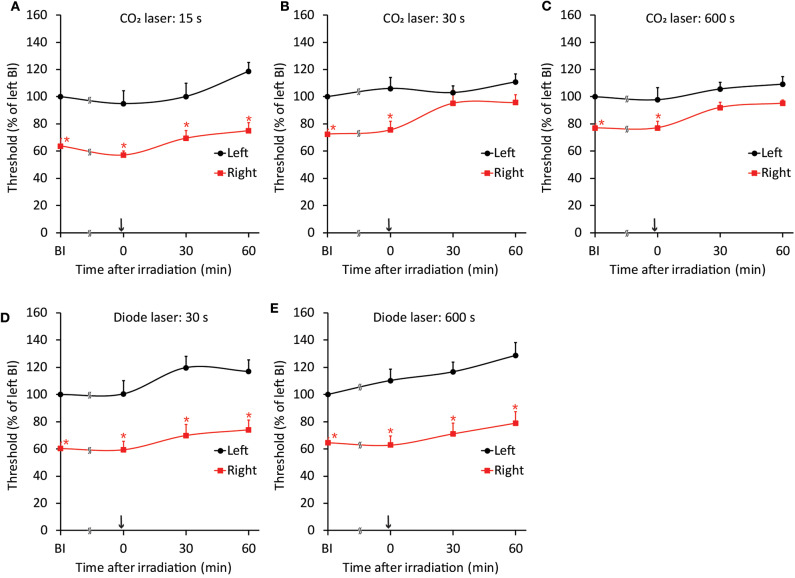
Effects of CO2 or diode laser irradiation on orthodontic treatment-induced excitation of the jaw-opening reflex. (A–C) One day of orthodontic force application significantly reduced the right-side threshold for inducing the jaw-opening reflex before irradiation. CO2 laser irradiation of the maxillary first molar region for 15 s (A) failed to alter jaw-opening reflex excitability. However, 30 (B) and 600 (C) s of CO2 laser irradiation significantly increased the right-side threshold for inducing the jaw-opening reflex. (D,E) Thirty seconds (D) or 600 s (E) of diode laser irradiation failed to increase the right-side threshold for inducing the jaw-opening reflex. BI: before irradiation. Arrow: laser irradiation. Two-way ANOVA, side: p < 0.05, time: p < 0.05, side × time: p < 0.05; Dunnett's post hoc test, *p < 0.05: vs. “BI of left”.